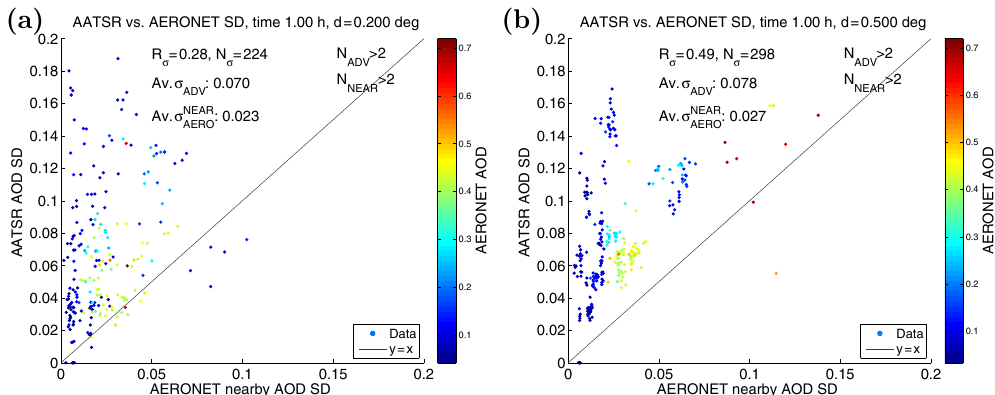
Figure 5. Comparison of spatial aerosol variability estimates between AATSR and AERONET, calculated from the standard deviation of AOD within the sampling distance, for d = 0 . 2 ◦ (a) and d = 0 . 5 ◦ (b) . The temporal sampling window used here is ± 1h, and at least three observations in the spatial sampling area are required for each data source ( N ADV > 2 and N NEAR > 2). The color shows AERONET AOD at 555nm. Higher AOD values are generally associated with higher variability.